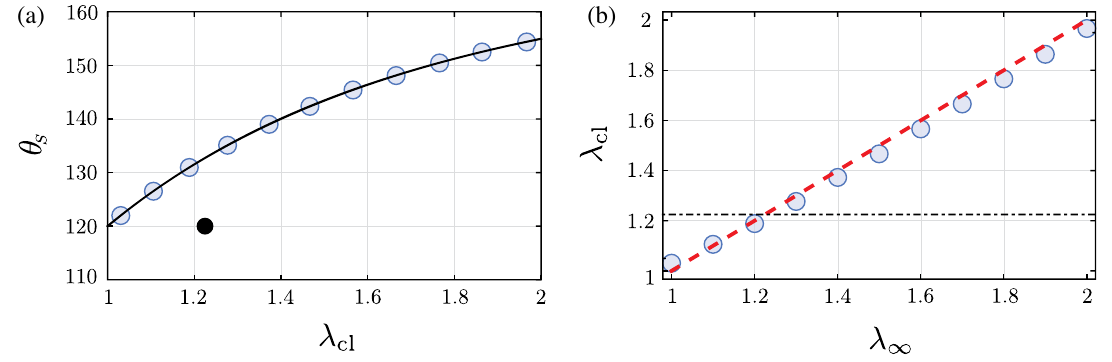
FIG. 2. Geometry of the elastocapillary ridge upon stretching the substrate. (a) Solid angle θ line λ . Open circles correspond to FEM in the presence of a strong Shuttleworth effect ( c 0 ¼ c 1 ¼ 1 , with γ 0 ¼ γ cl the analytical prediction by Neumann ’ s law (15). The closed circles (several measurements superimposed) correspond to FEM without a Shuttleworth effect ( c 0 ¼ c 1 ¼ 0 , with γ 0 ¼ γ stretch λ ∞ . In the presence of a strong Shuttleworth effect, the two stretches takes on very similar values (the red dashed line, λ a guide to the eye). Without a Shuttleworth effect, λ